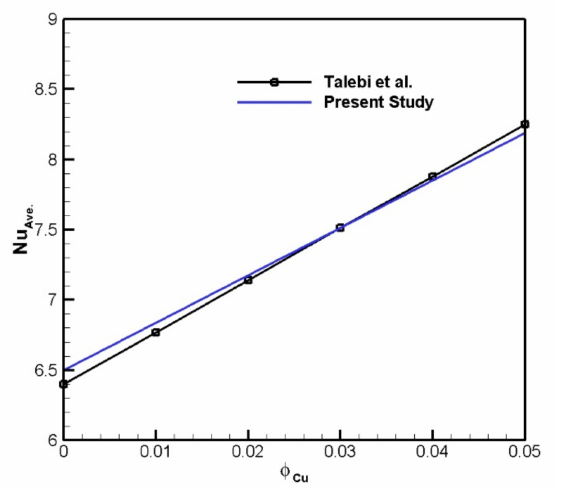
Figure 4. Average Nu versus volume fraction of Cu nanoparticles for Re = 100 and Ra = 1.47 × 10 4